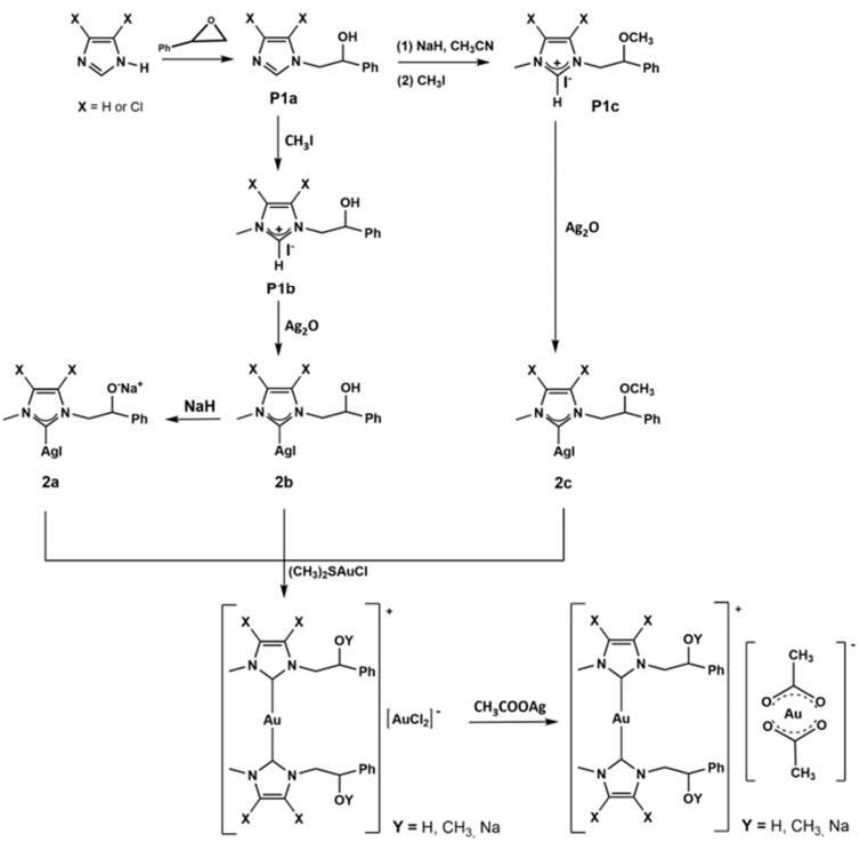
Figure 1. New synthesized Au N -heterocyclic (NHC) carbene complexes.